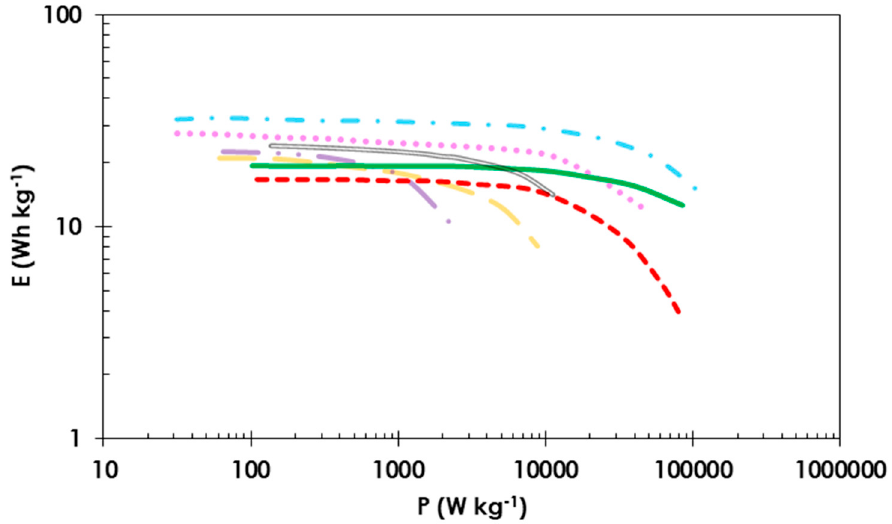
Figure 7. Comparative Ragone plot for EDLC cells in which starch ( solid green line ) or CMC ( dashed red line ) was used as a binder. Cells were tested up to 2.5 V in 1 mol L − 1 TEABF 4 in ACN. Composition of electrode material 80 wt. % activated carbon (YP 80F) 10 wt. % carbon black (Super C65) and 10 wt. % binder. The reference curves were made according to the data from: [63] ( dot-dashed light blue line ), [64] ( double grey line ), [65] ( dotted light pink line ), [66] ( long dashed light orange line and dot-dot-dashed light purple line ).